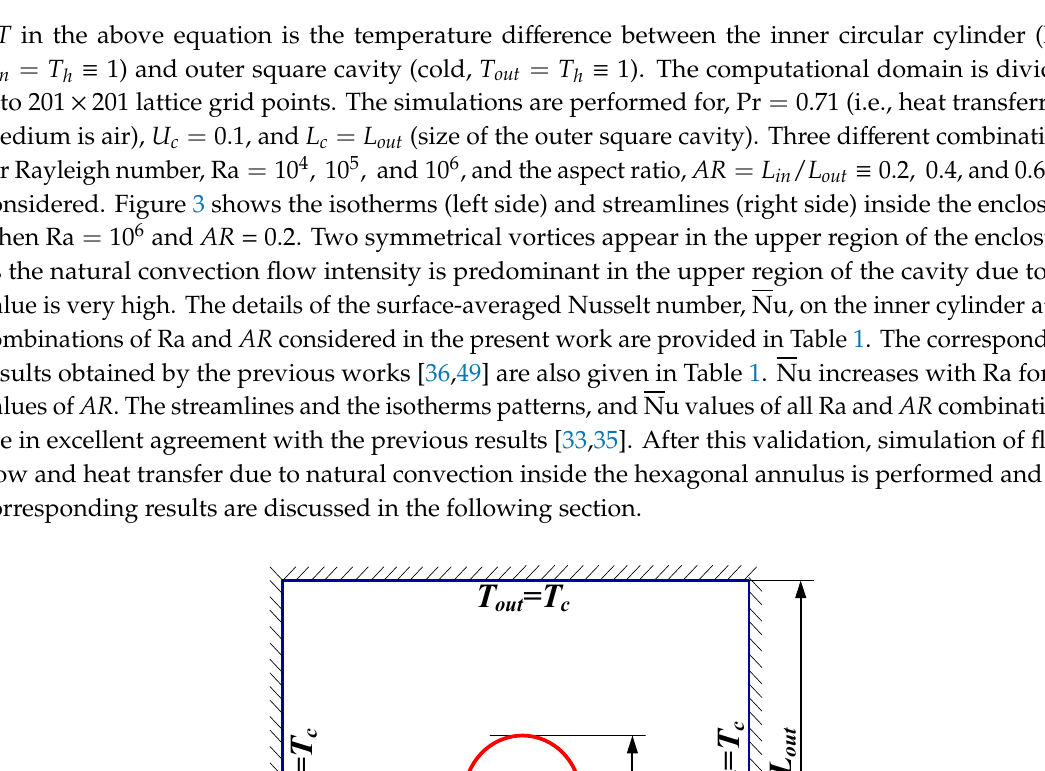
Figure 3. Isotherms (left side) and streamlines (right side) patterns inside the square enclosure when Rayleigh number is, 6 Ra 10 = , and aspect ratio, AR = 0.2. Table 1. The details of the surface average Nusselt number, Nu , on the inner cylinder at different combinations of Ra and AR . Ra